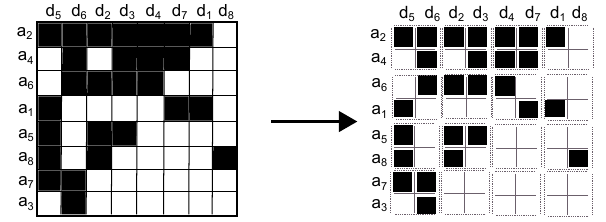
Figure 3. Step 3. Example of splitting the image into 2 × 2 square